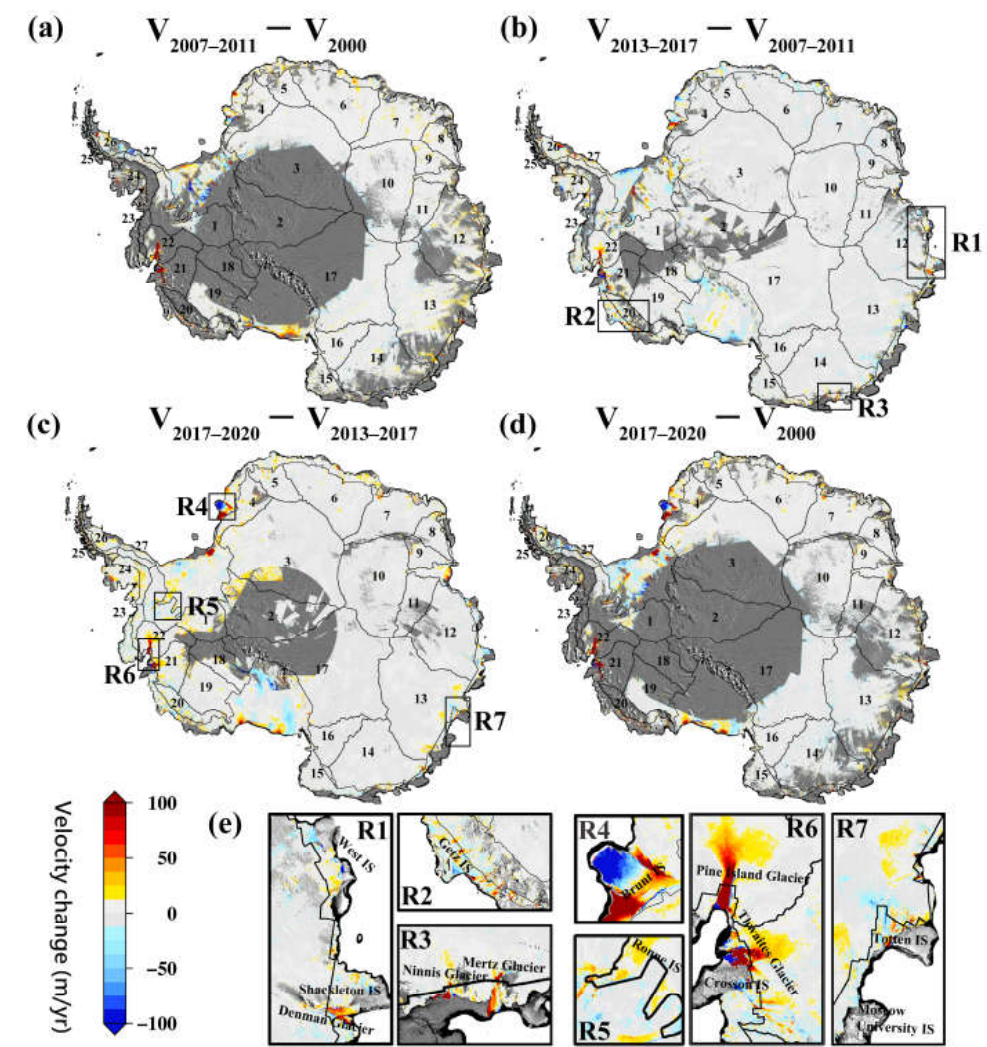
Figure 4. Antarctic-wide ice velocity changes in four different periods: ( a ) from 2000 to 2007–2011; ( b ) from 2007–2011 to 2013–2017; ( c ) from 2013–2017 to 2017–2020; ( d ) from 2000 to 2017–2020. The black rectangles show the locations of R1–R7 in ( e ). The black line is the basin boundary produced with the flux gate. ( e ) Seven regions (R1–R7) with significant changes.